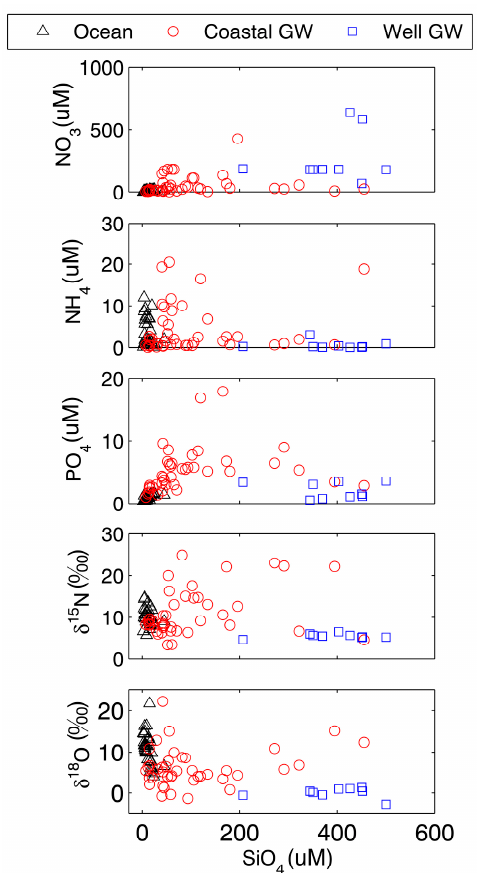
Figure 3. Nutrient concentrations and δ 15 N NO3 and δ 18 O NO3 plotted against silicate concentrations, the solute best indicative of conservative mixing. Fits of linear regressions were low (R 2 < 0.25).